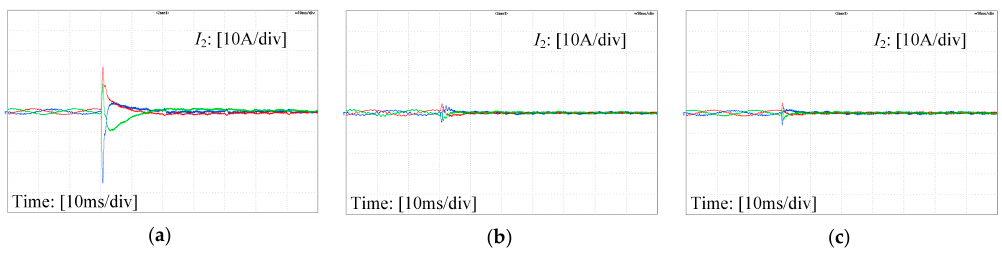
2d = 0. ( a ) NFF; ( b ) SCVDFF;